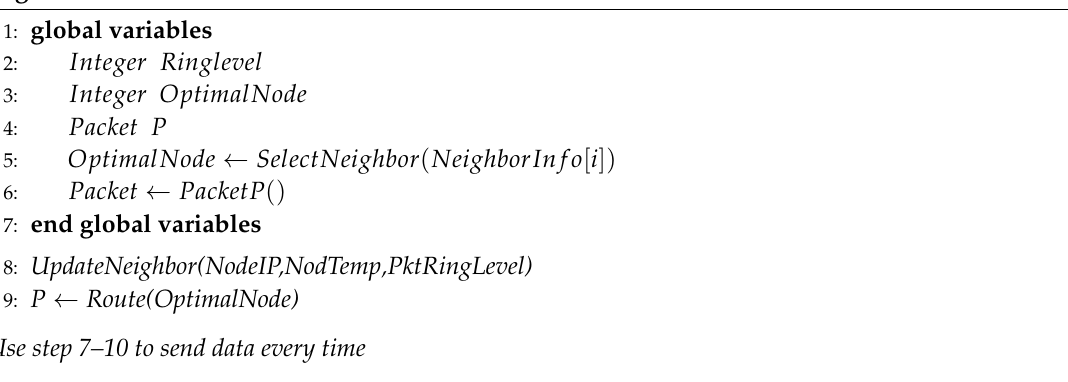
Algorithm 3 On Receiving Data Packet.